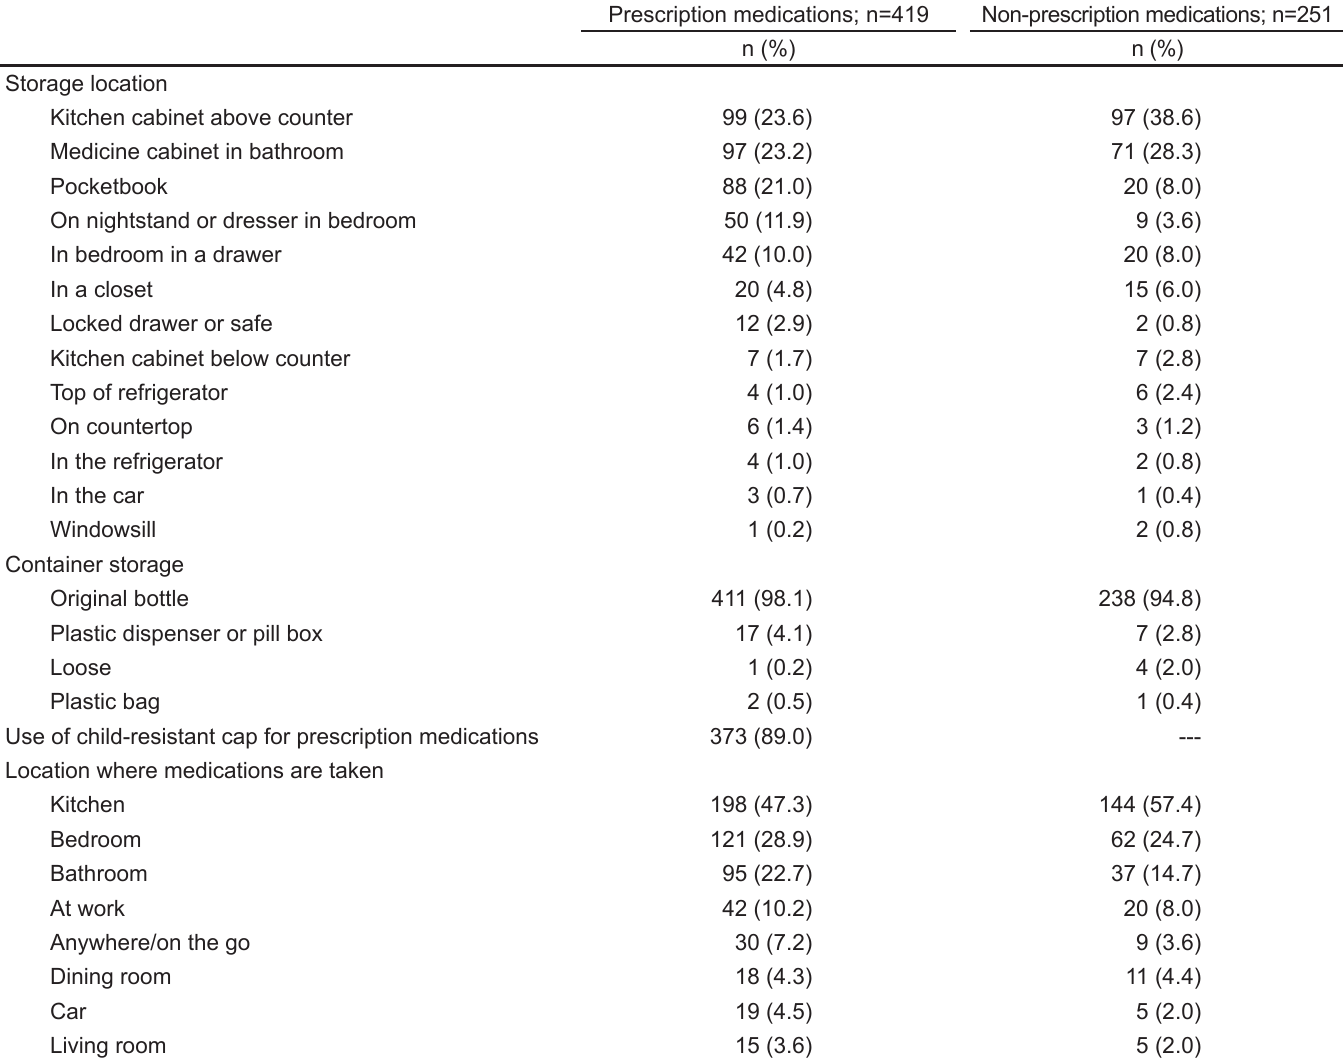
Table 3. Storage of medications and location where medications are taken by participants who live with the